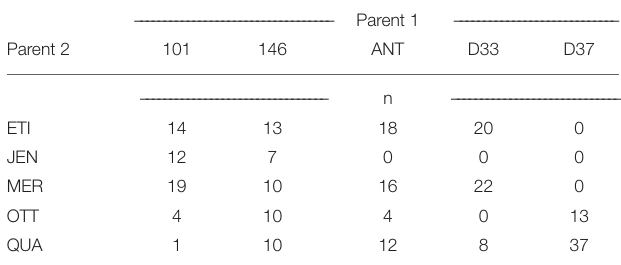
TABLE 1 | Size n of the families of DH lines derived from the crosses of Parent 1 x Parent